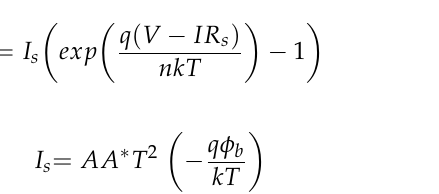
Figure 3. Variation of reverse leakage current and threshold voltage versus temperature.